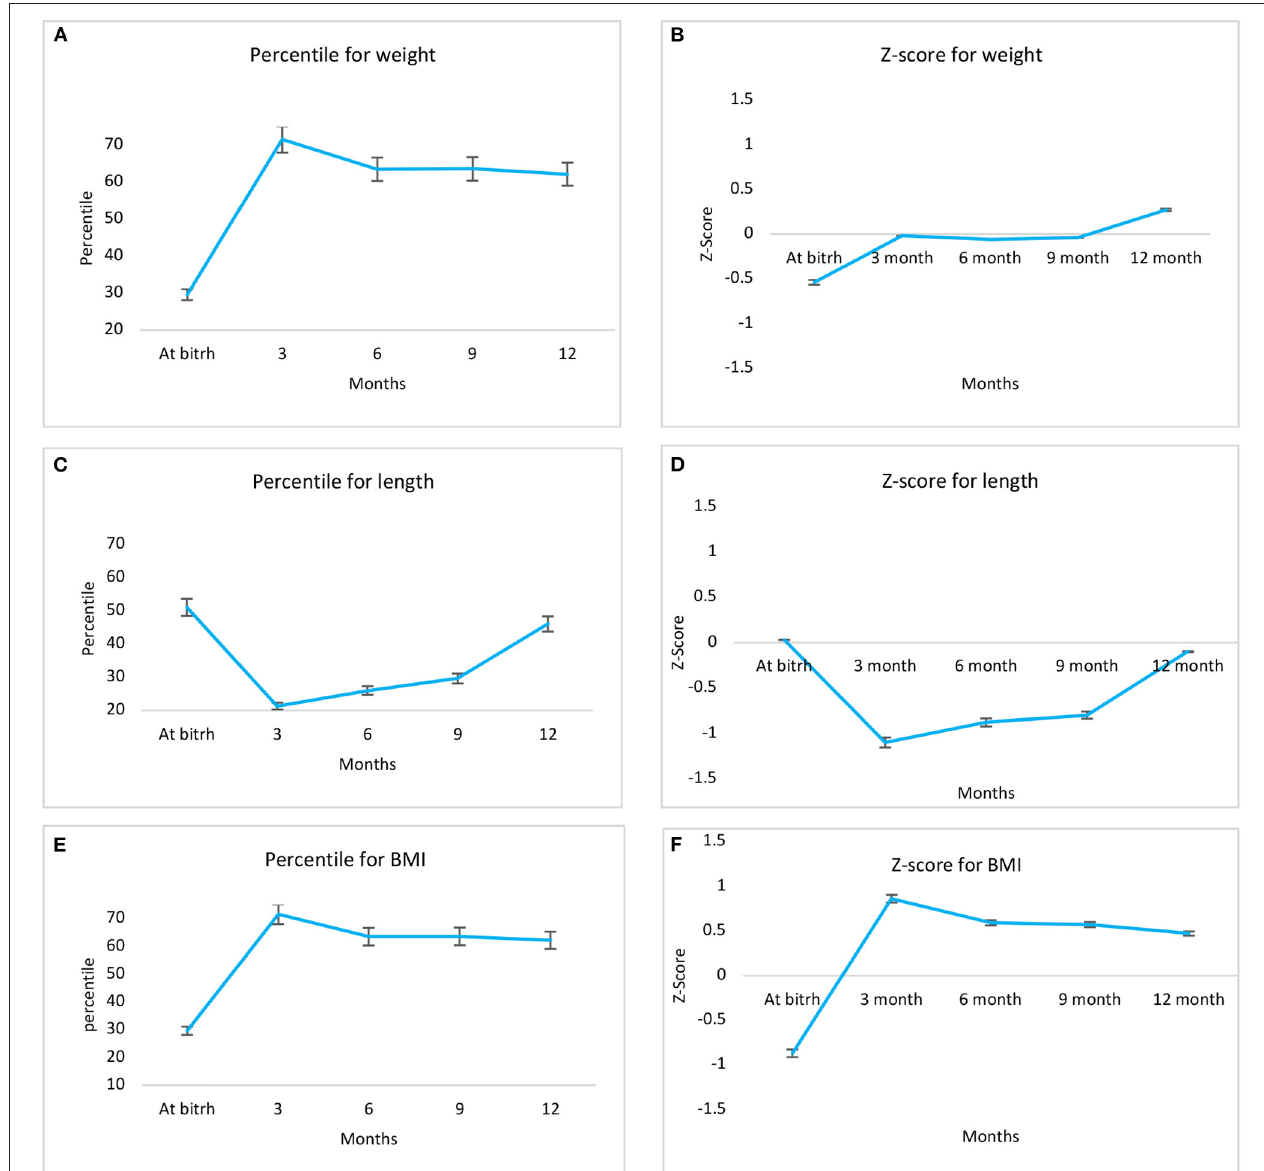
FIGURE 1 | Trends in weight, length and BMI in percentiles (left panel A,C,E) and Z-score (right panel B,D,F) , from birth to 12 months in adolescents’ offspring.